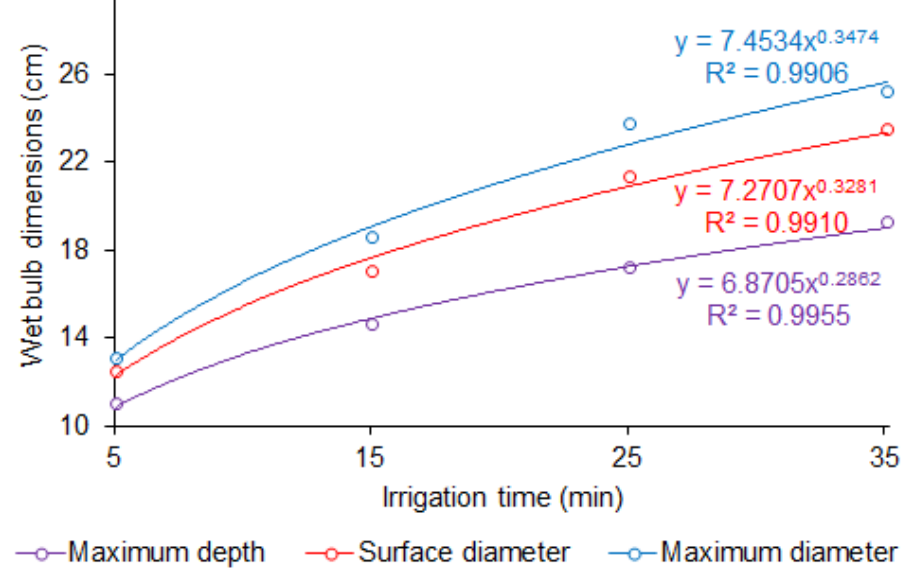
Figure 6. Wet bulb dimensions as a function of water application time in sandy clay soil irrigated using drippers with a flow rate of 2 L h − 1 .